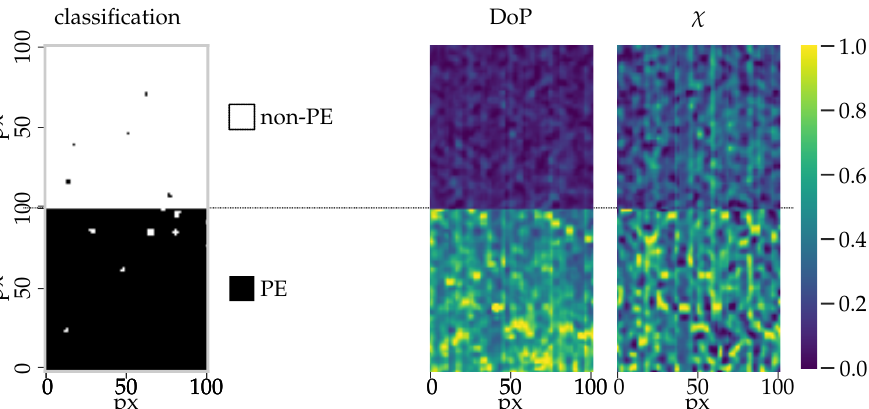
Figure 11. Test dataset with non-PE- and PE-coated paperboard samples (left–right): model classifi- cation, DoP, and χ . The values of the features have been normalized to a range of 0 to